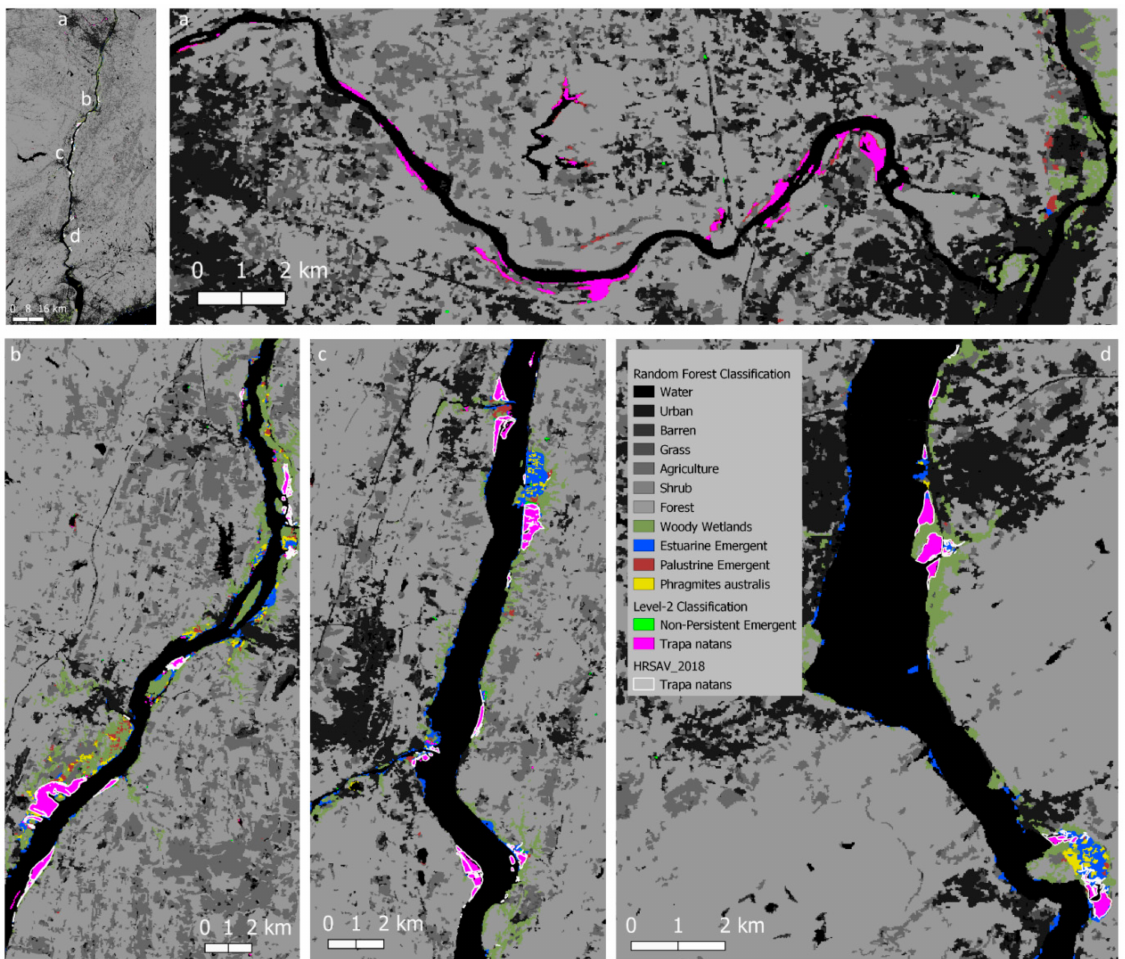
Figure 15. Comparison between Hudson River classified T. natans extents in level-2 classification and independent validation with 2018 HRSAV dataset. The small panned map in the upper left corner shows the Hudson River and locations of panels ( a – d ). Panel a showcases classified T. natans extent in the Mohawk River, a tributary to the Hudson River; note that the HRSAV dataset does not cover this site. T. natans occurrence accuracy was